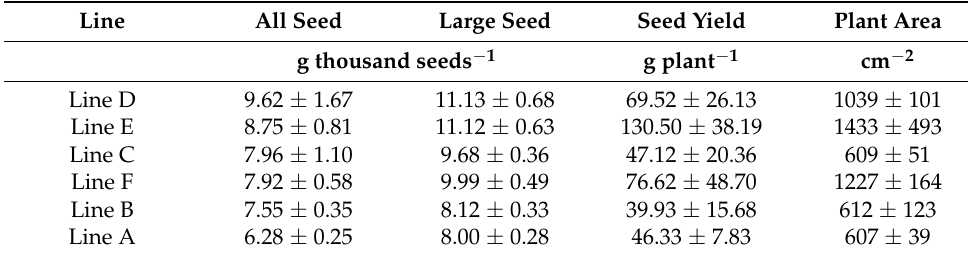
Table 1. Overall mean thousand seed weight (TSW) for half-sibling lines of intermediate wheatgrass lines, TSW for the large seed portion, seed yield plant − 1 and plant area harvested over three years at Carman,